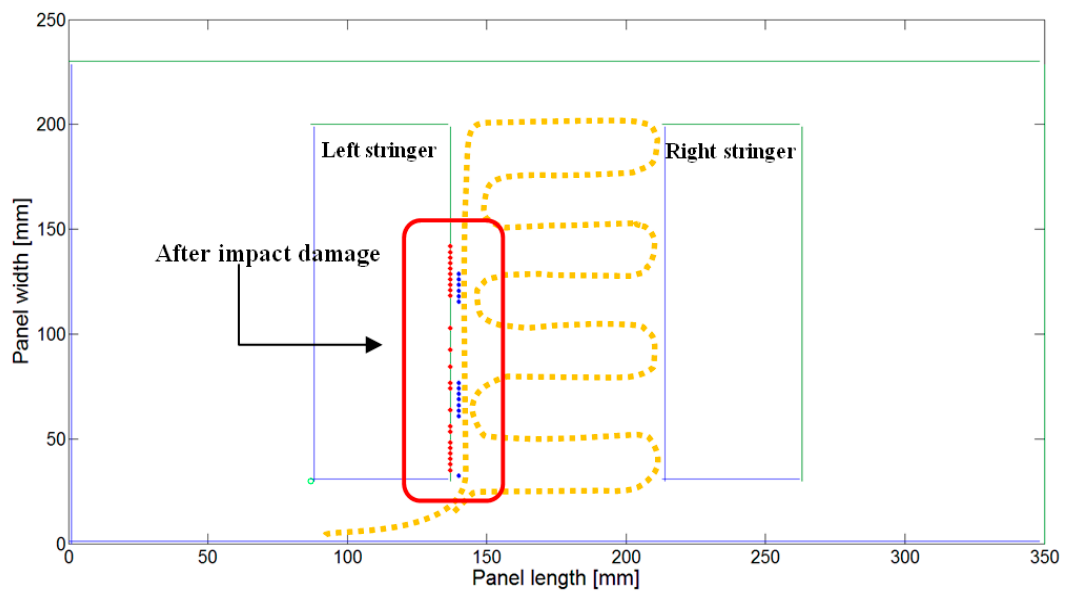
Figure 15. Graphical user interface of the panel geometry and fiber optic layout (yellow dotted line). The red and blue dots are the sensors with higher DI value.